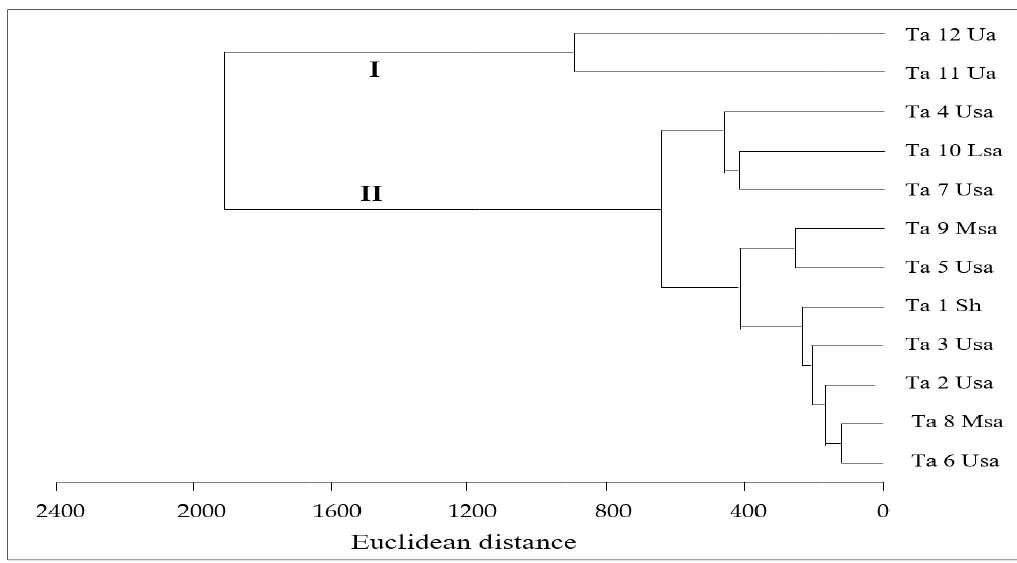
Figure 2. Cluster analysis performed on phenolic compounds of T. algeriensis extracts. Ta 1–12 correspond to the code number as detailed in Table 1. Sh, Usa, Msa, Lsa, and Ua correspond to sub humid, upper semi-arid, mean semi-arid, lower semi-arid, and upper arid bioclimatic zones, respectively (See Table 1).